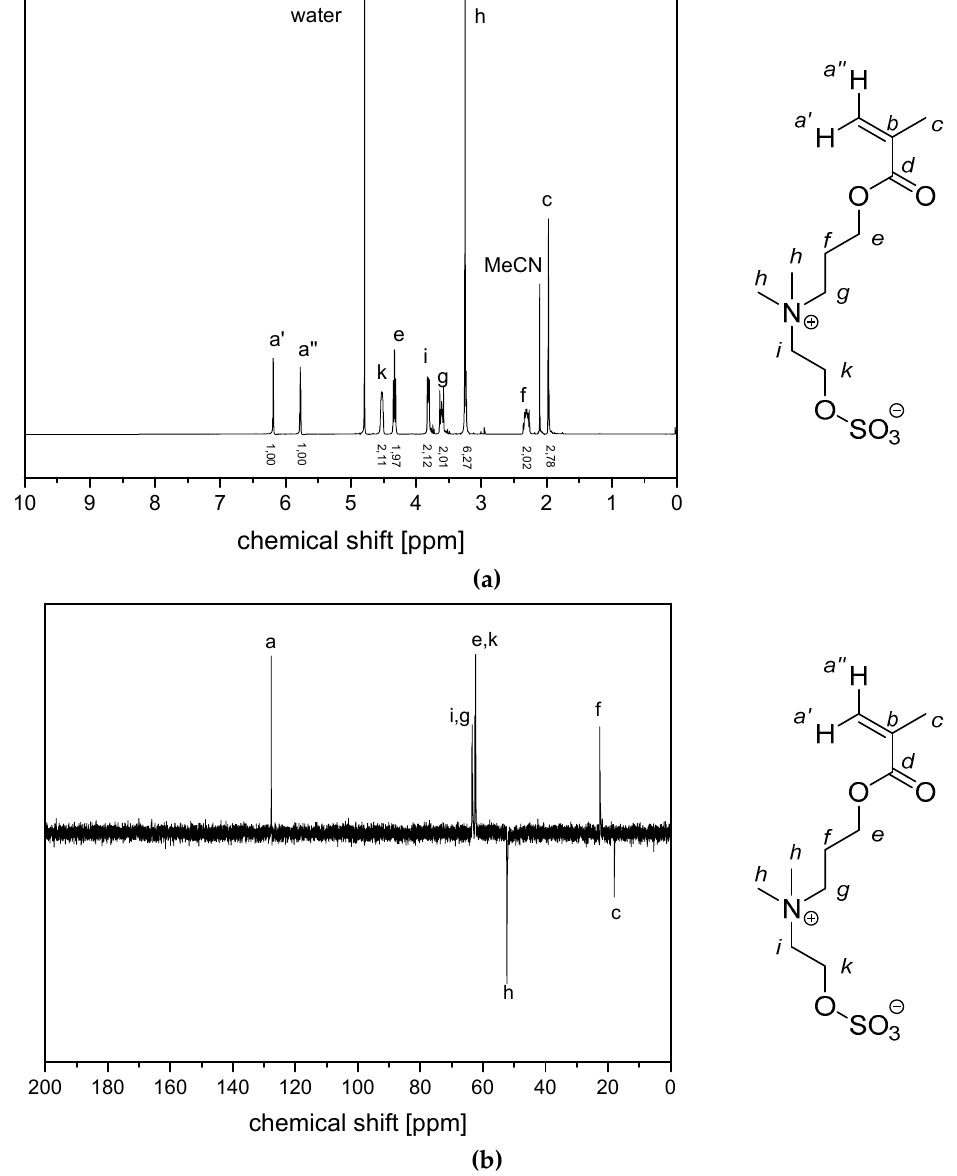
Figure A1. ( a ) 1 H NMR- spectra and ( b ) 13 C (APT) NMR-spectra of monomer 2c in D 2 O.